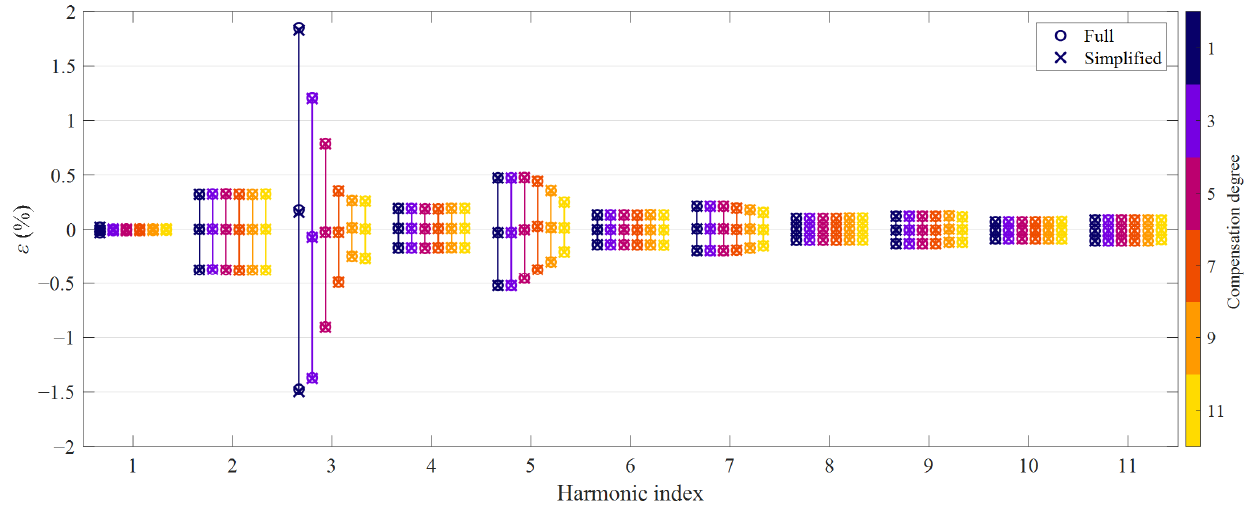
Figure 4. Phase displacement achieved with the proposed HD compensation methods: odd degrees from 1 to 11, average values and 95th percentile bands (numerical simulations).